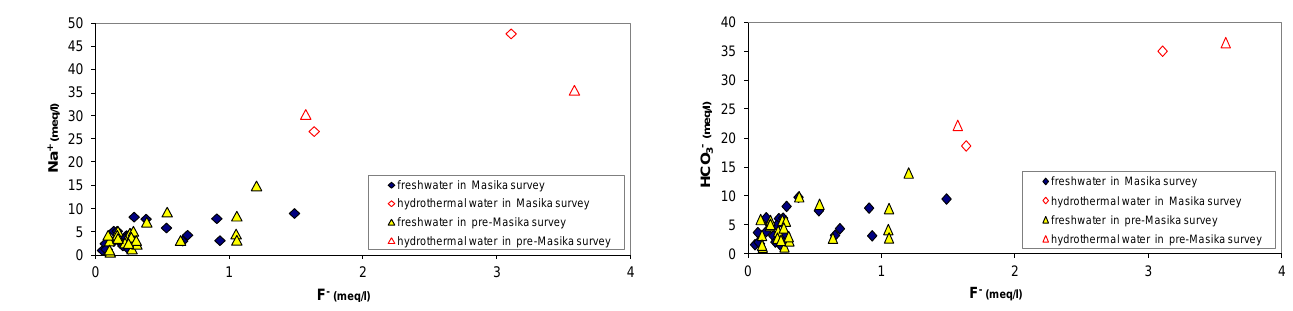
Fig. 5. Bicarbonate vs. fluoride scatter diagram of all groundwater samples.